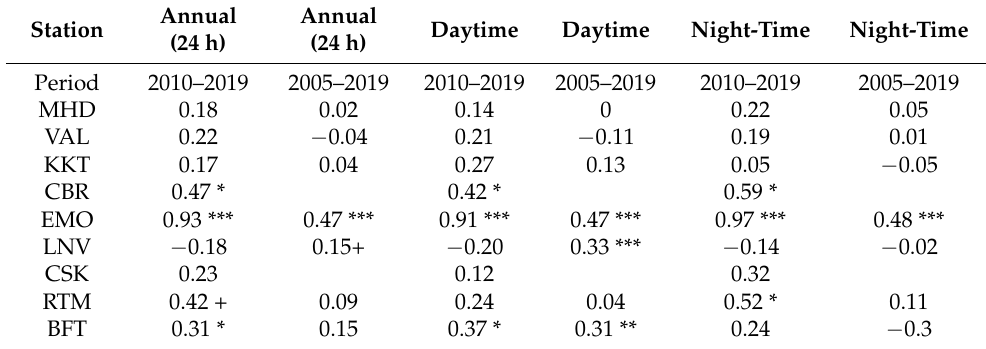
Figure 5. Five-year (2015–2019) hourly mean ozone (O 3 ) concentrations ( µ g/m 3 ) for: ( a ) urban stations (BFT, CSL, RTM); ( b ) Atlantic stations (MHD, VAL); ( c ) rural stations (EMO, KKT, LNV); and ( d ) suburban stations (CBR, CSK, SVL). All stations followed a daily pattern of mid-morning minimum, and late afternoon maximum. See Table 1 for station ID codes. Table 2. Long-term Thiel-Sen slope over ten years (2010–2019) and 15 years (2005–2019) for annual, daytime, and night-time ozone concentrations. Positive values indicate increases and negative values indicate decreases ( µ g/m 3 per year) in the Thiel-Sen slope, with asterisks indicating levels of significance. See Table 1 for station ID